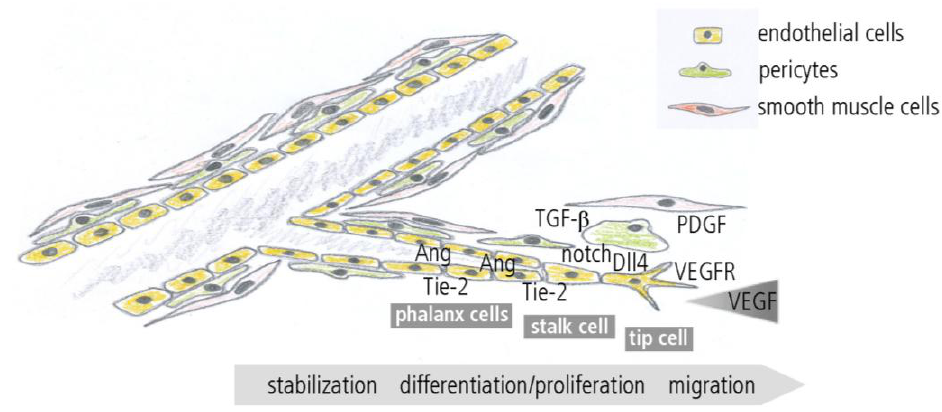
FIGURE 2. Postnatal angiogenesis is organized by the concerted action of different angiogenic